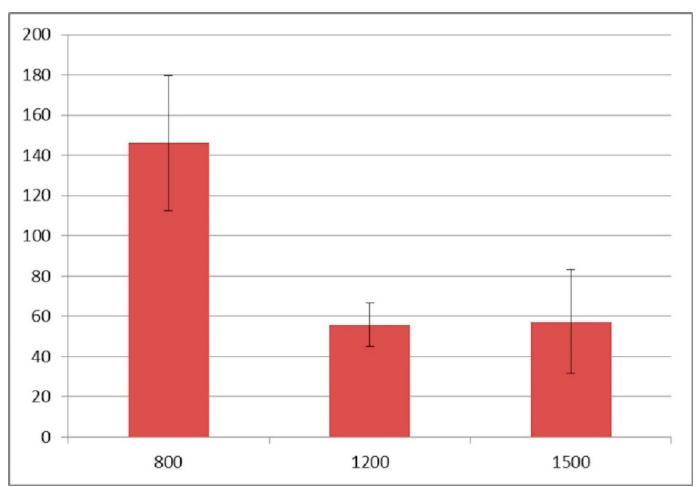
Figure 8. The thickness of the damage zone in the tested drilling speeds [µm].